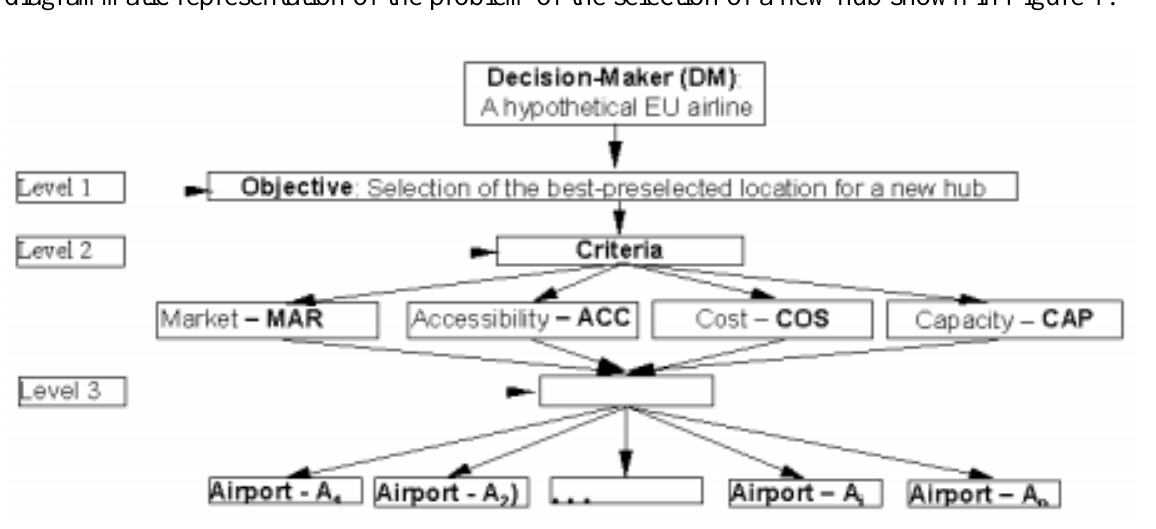
Figure 1. The AHP method: hierarchical structuring of the MCDM problem for a given